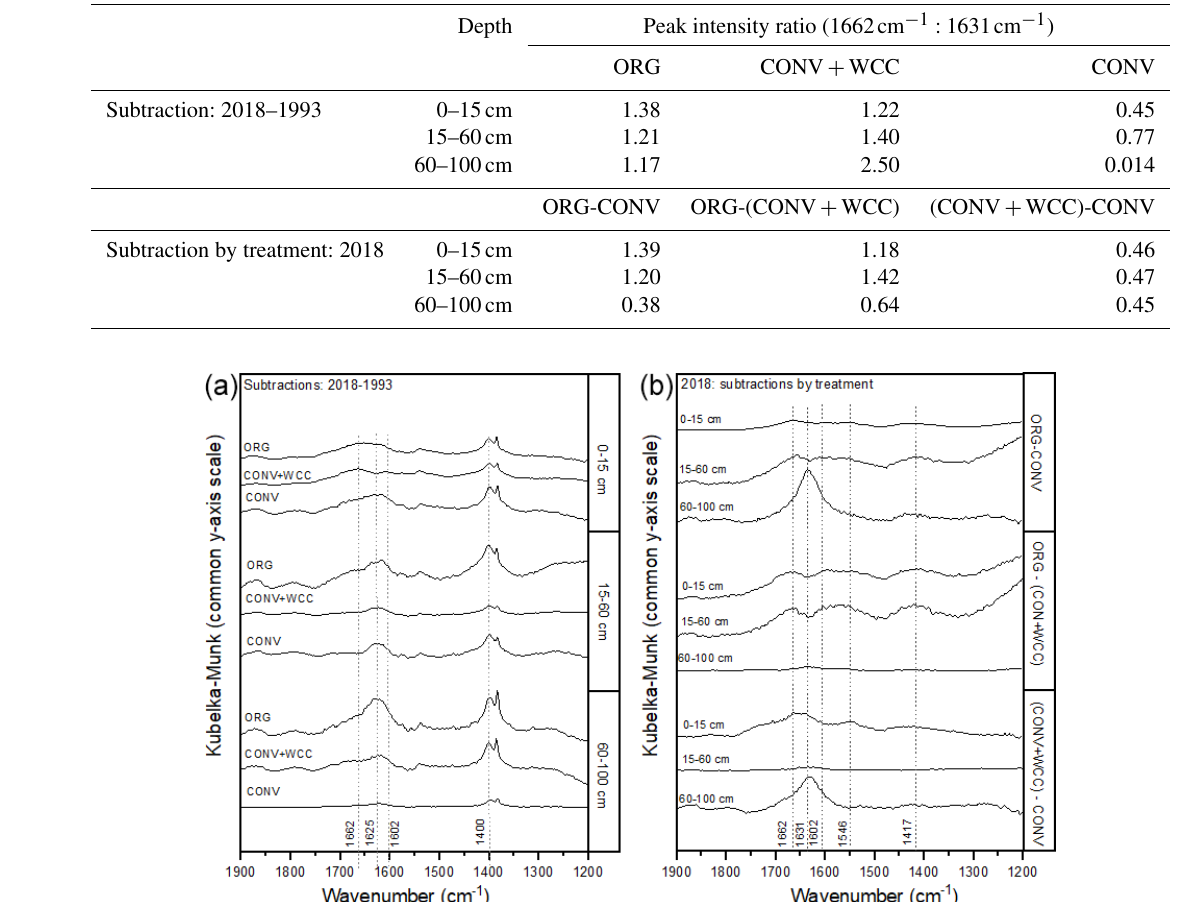
Figure 8. (a, b) DRIFT spectral subtractions for the 1900–1200cm − 1 range comparing (a) 2018–1993 spectra for ORG, CONV + WCC, and CONV and (b) ORG, CONV + WCC, and CONV spectra in 2018. Spectra are plotted with Kubelka–Munk units on a common y -axis scale and are offset from one another for ease of